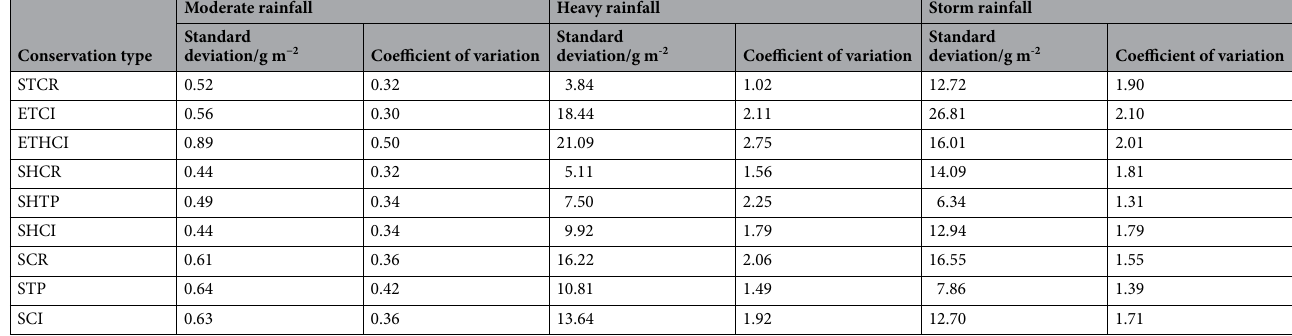
Table 5. Statistical features of erosion modulus for runoff plots under different rainfall